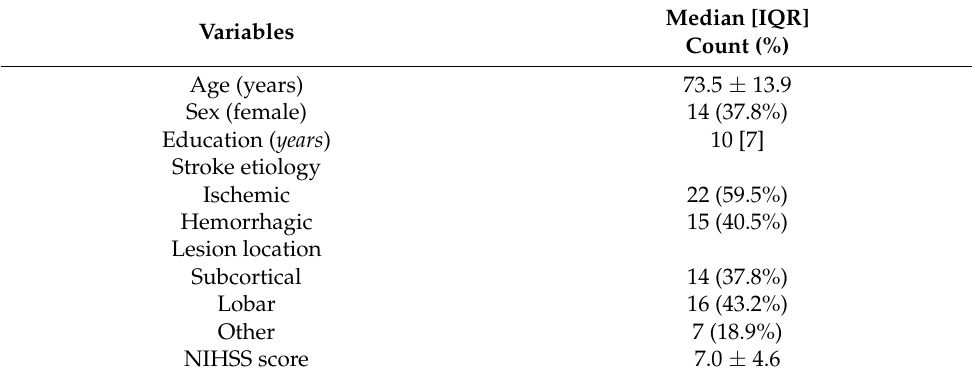
Table 1. Demographic and clinical characteristics of the sample ( n =